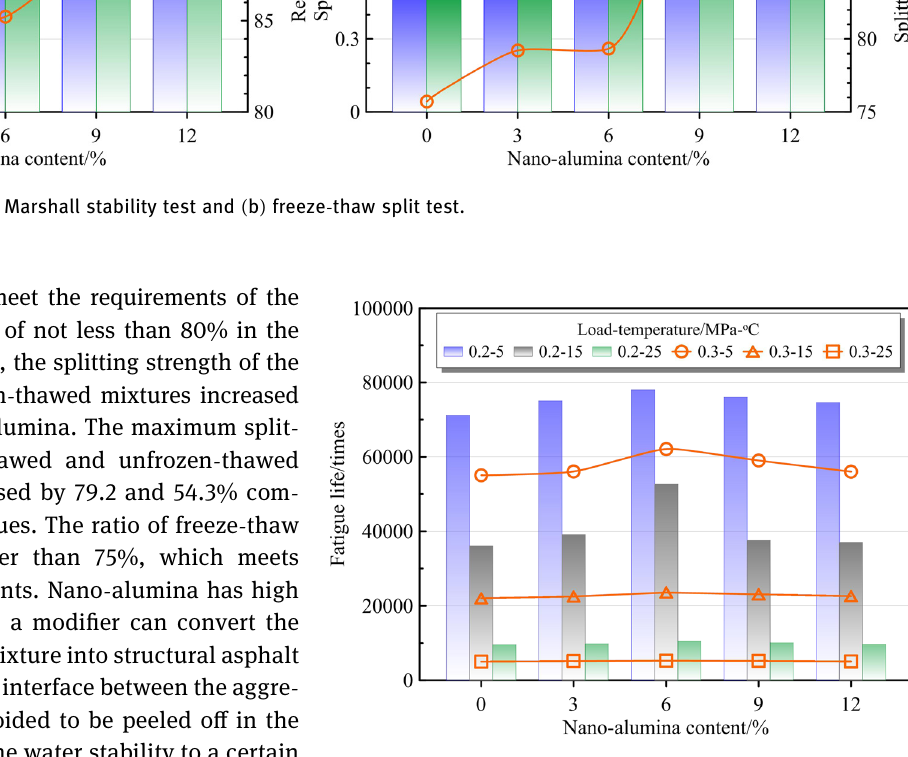
Figure 5: Fatigue life of asphalt